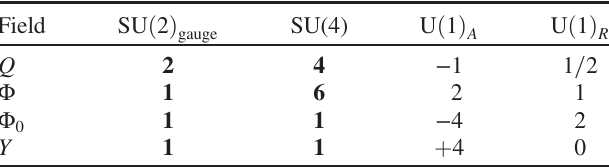
TABLE V. Quantum numbers of the 3D field theory.